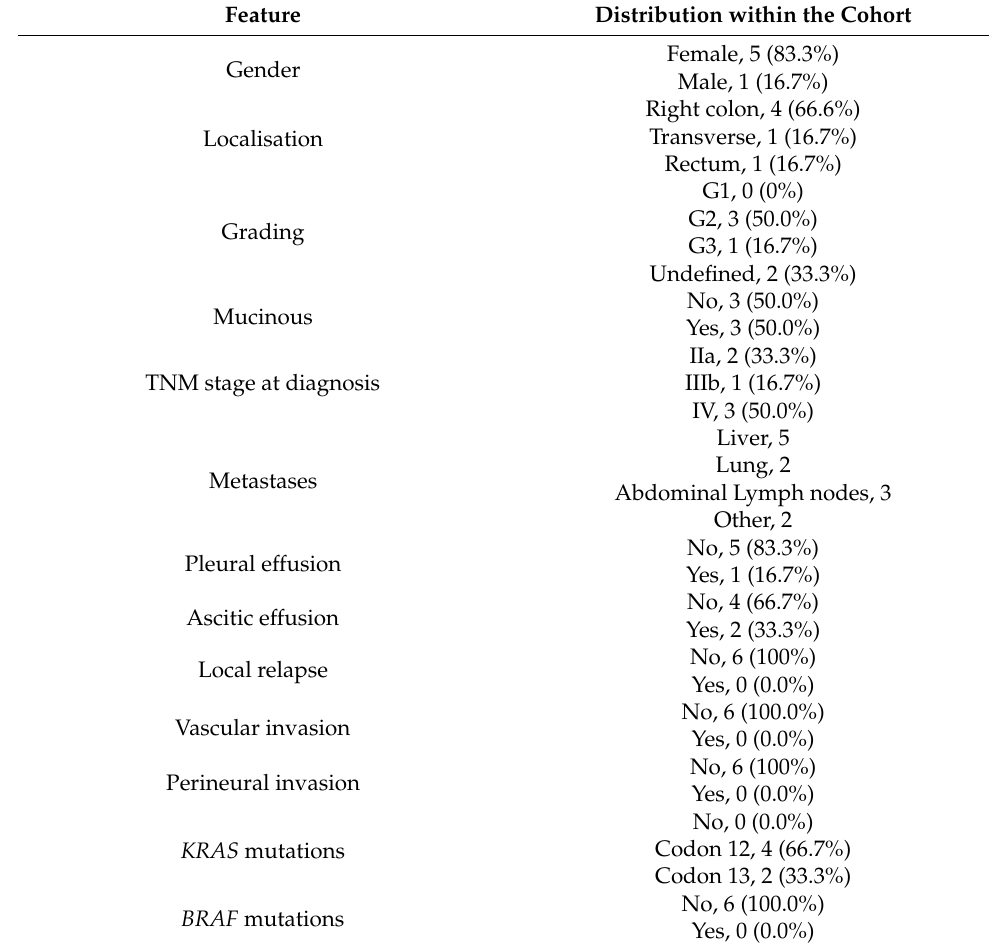
Table 1. Demographic and clinical features of the patients enrolled in the